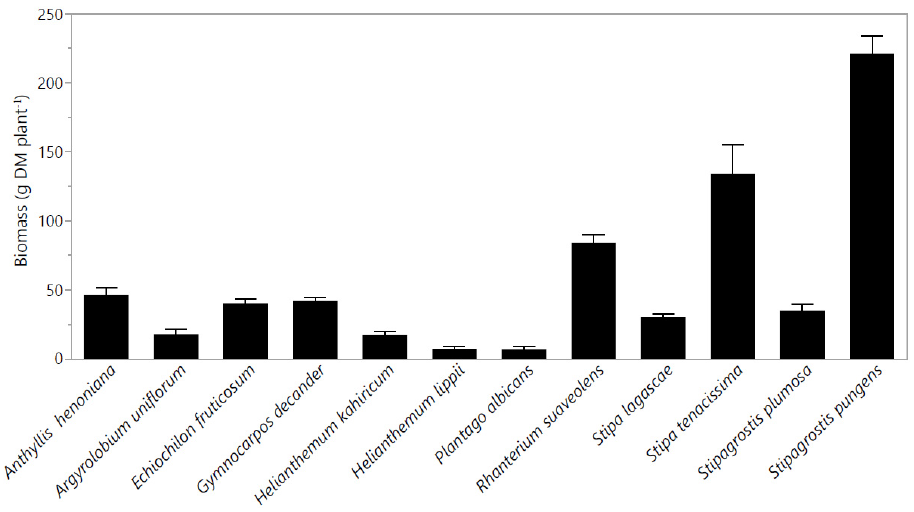
Figure 2. Biomass (g DM plant − 1 ) of twelve native perennial species from arid rangelands of southern Tunisia. Values are the means ± standard error (SE) from 3 replicates (means ± SE). Fodder biomass was correlated with plant height (r = +83, p < 0.0001), plant length (r = +0.93, p < 0.001), and plant vegetation cover (r = +91, p < 0.0001; Figure 3). Figure 3. Correlation coefficients between yield attributes of twelve native perennial species from arid rangelands of southern Tunisia. 2.2. Chemical Composition The chemical composition of the twelve species is shown in Figure 4. When compared with Stipa species, the foliage of R. suaveolens , H. lippii , and E. fruticosum species tends to be more nutritious. Considerable variation in CP concentration was observed